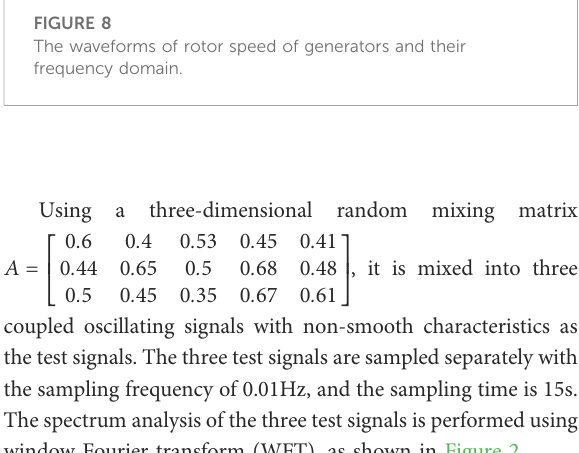
FIGURE 8 The waveforms of rotor speed of generators and their frequency